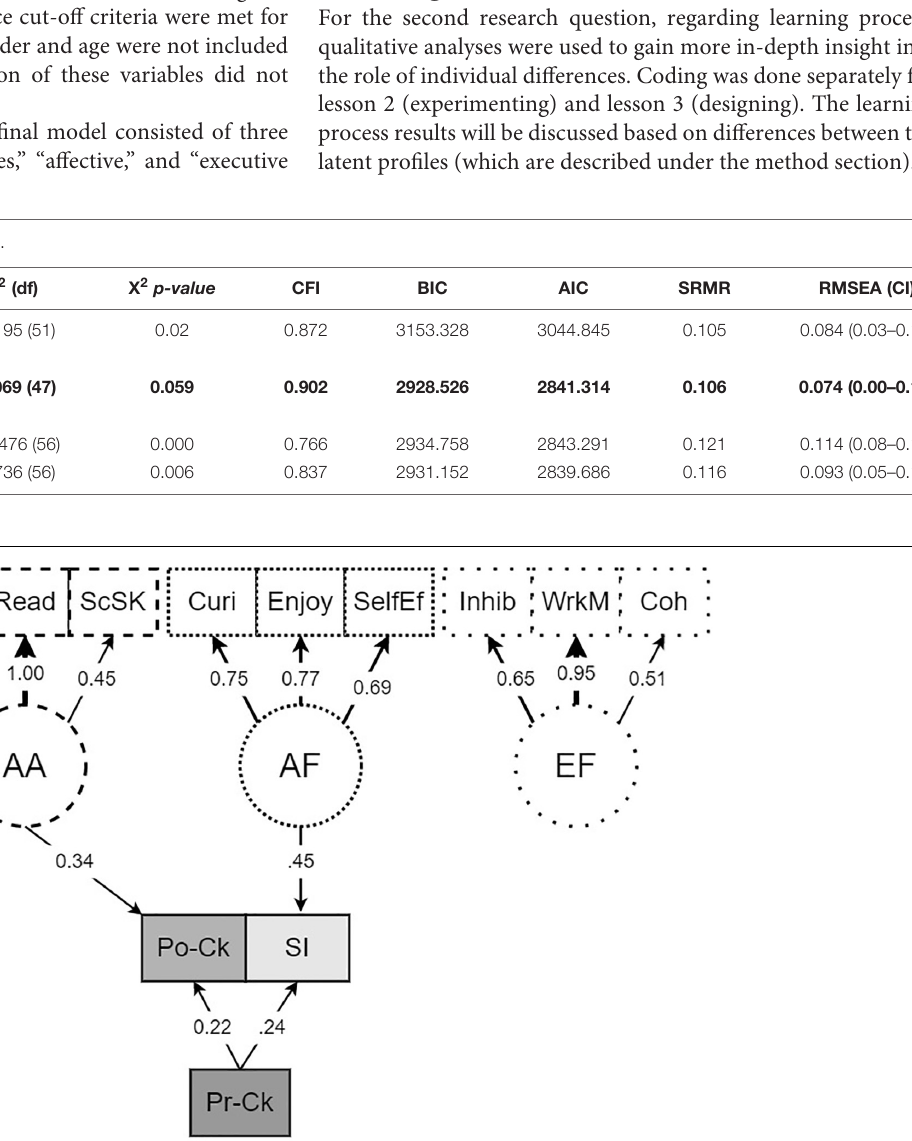
Table 6 . The pseudo fit indices for the final model: X 2 (47) = 63.07,